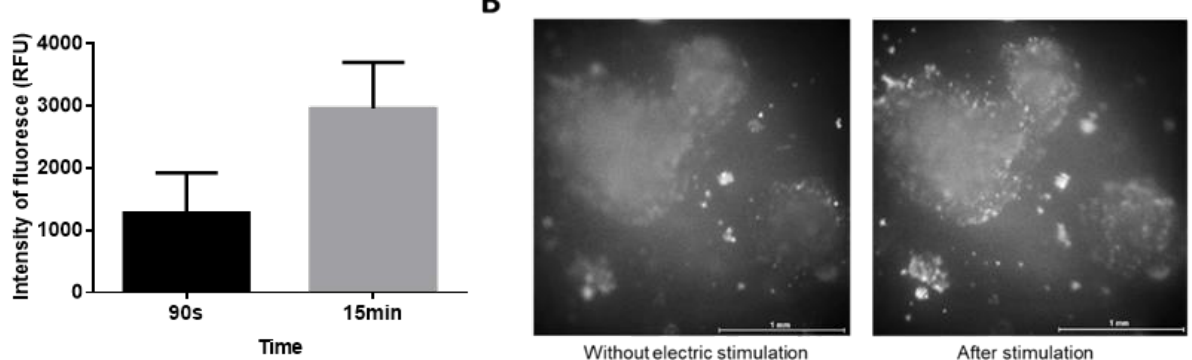
Figure 3. Elevation of cytosolic-calcium level under electrostimulation: EBs adhered to PEDOT:PSS platform wells (6 d) were loaded with calcium-sensitive probe Fluo-4 AM. The change in fluorescence upon stimulation with electric pulses (square wave, 1 Hz, 200 mV/mm, pulse duration 100 ms) recorded with a fluorescence microscope connected with camera. The record was processed in ImageJ software. ( A ) The chart shows typical data from three independent biological replicates. ( B ) Differences of fluorescence without electric stimulation and after stimulation for 15 min.